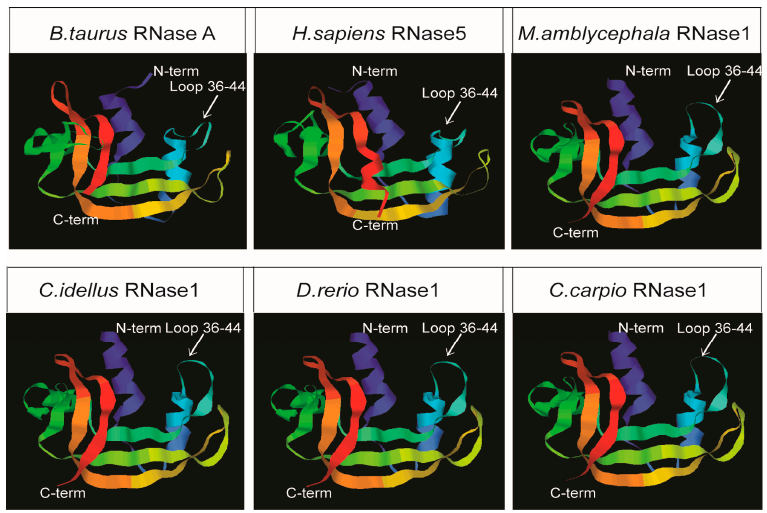
Figure 2. Ribbon representations of 3D structures of four fish RNase1 and two mammals RNase A. The blue, light blue and green ribbons represent the three α -helices and ribbons with others colors represent the six β -strands.